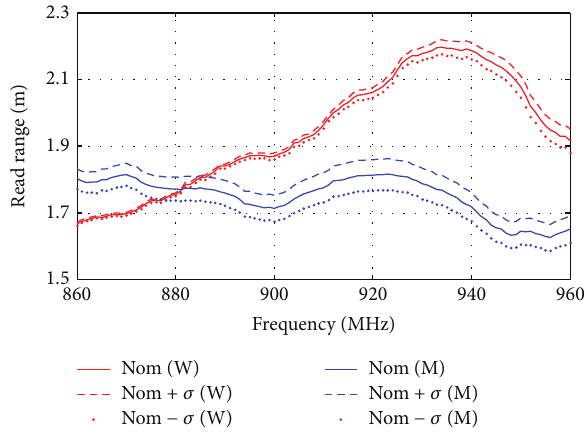
Figure 7: Reference response measurement results ( 𝐻 -plane) for theupperarmcaseforwoman(W)andman(M).Themeasurements are based on 20 repetitive threshold power measurements.